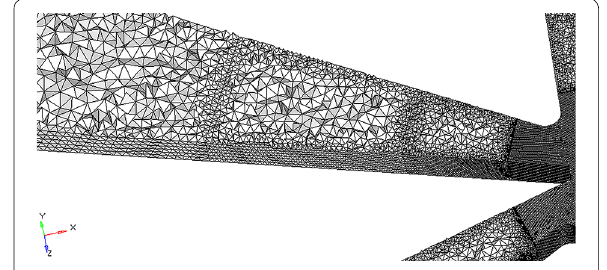
Figure 11 Receiver chamber’s tetrahedral meshes